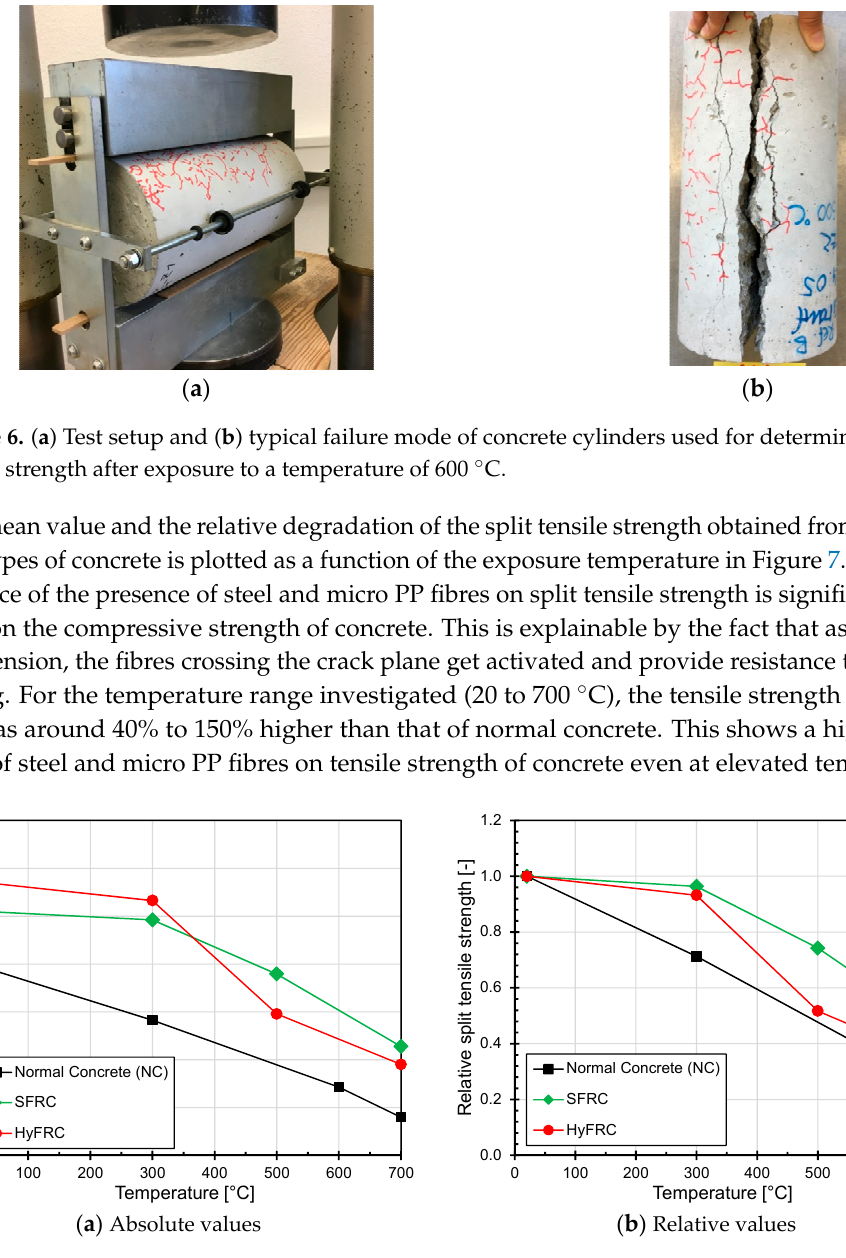
Figure 7. Influence of elevated temperature on split tensile strength of different types of concrete.